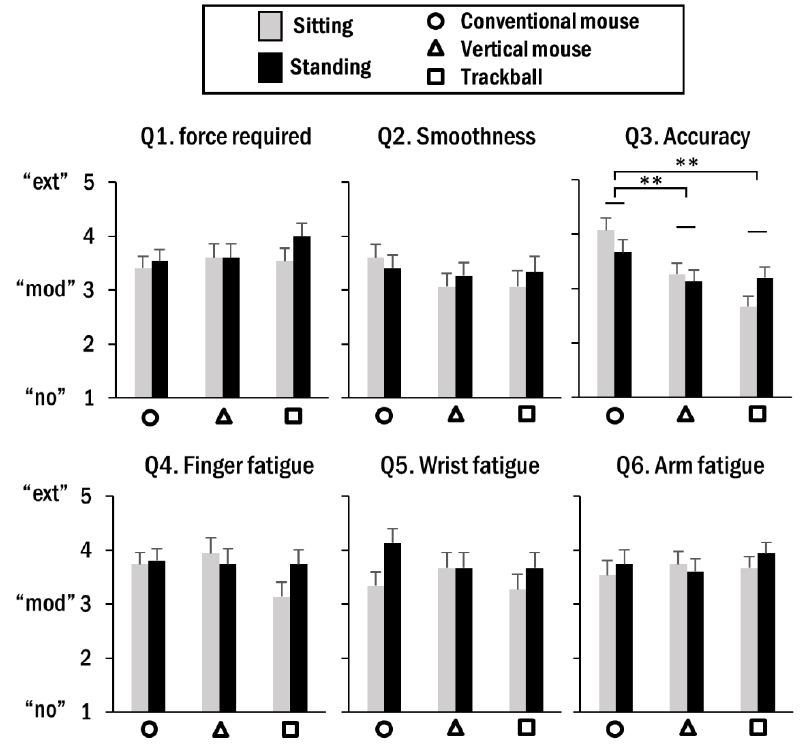
Figure 6. Average subjective ratings for force required for operation, smoothness of operation, accuracy, fatigue of finger, wrist, and arm. The labels on the vertical axis denote the level of each measure. The error bar indicates the SE and asterisks indicate significant difference between pointing devices (** p < 0.01).